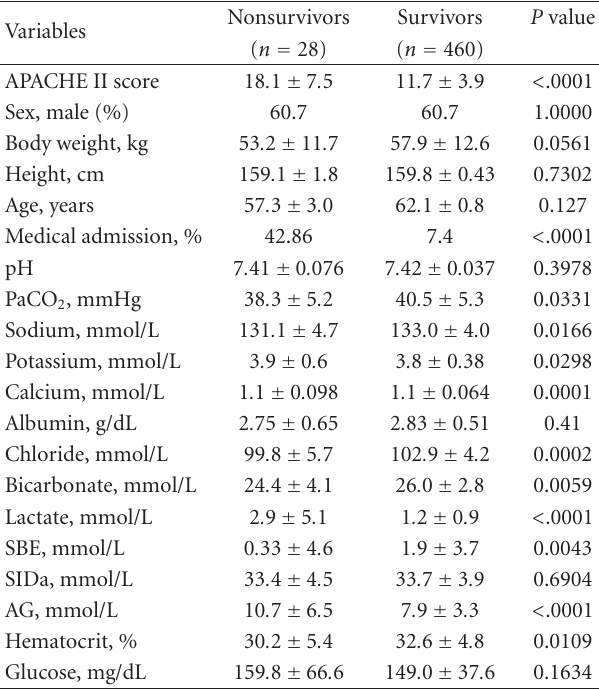
Table 4: Comparison of variables in surviving and nonsurviving patients in the hospital.